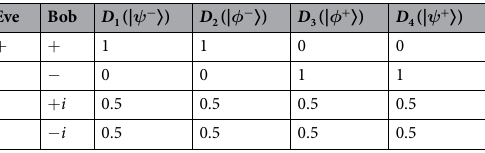
Schematics of hacking scheme. Figure 5 shows the proposed hacking scheme. Eve consists of copies of Alice (Alice’) and Bob (Bob’), which share bit and basis settings and a blinding laser. To perform our attack, Eve intercepts the state of Alice and randomly measures it in one of the two bases X and Y using the same devices as Bob. Eve then prepares new signals with detection results and the chosen basis from Bob’, overlaps them to a continuous-wave blinding laser which keeps Bob blind via an optical coupler C. Such detector blinding procedure and detector